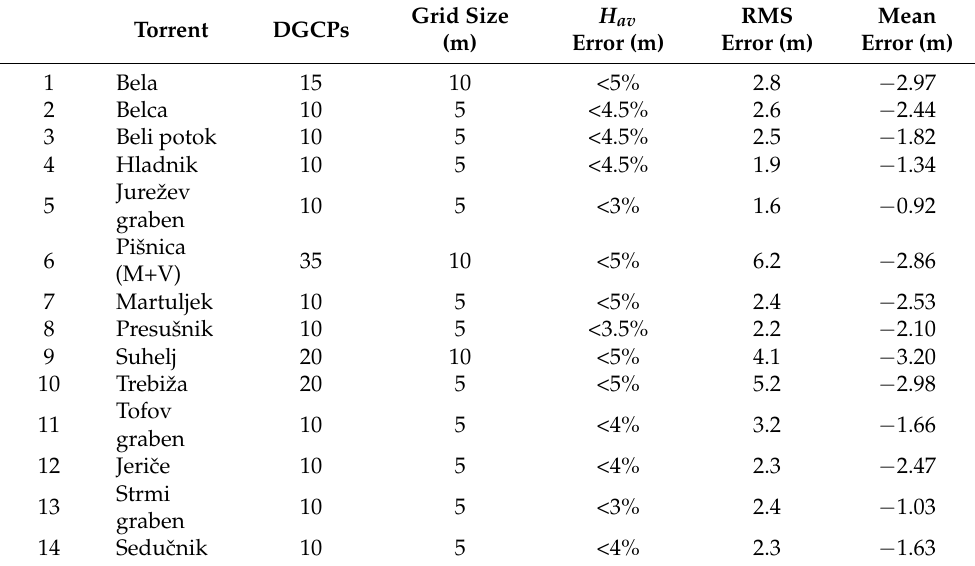
Table 2. Derived ground control points, grid size selection, and DEM